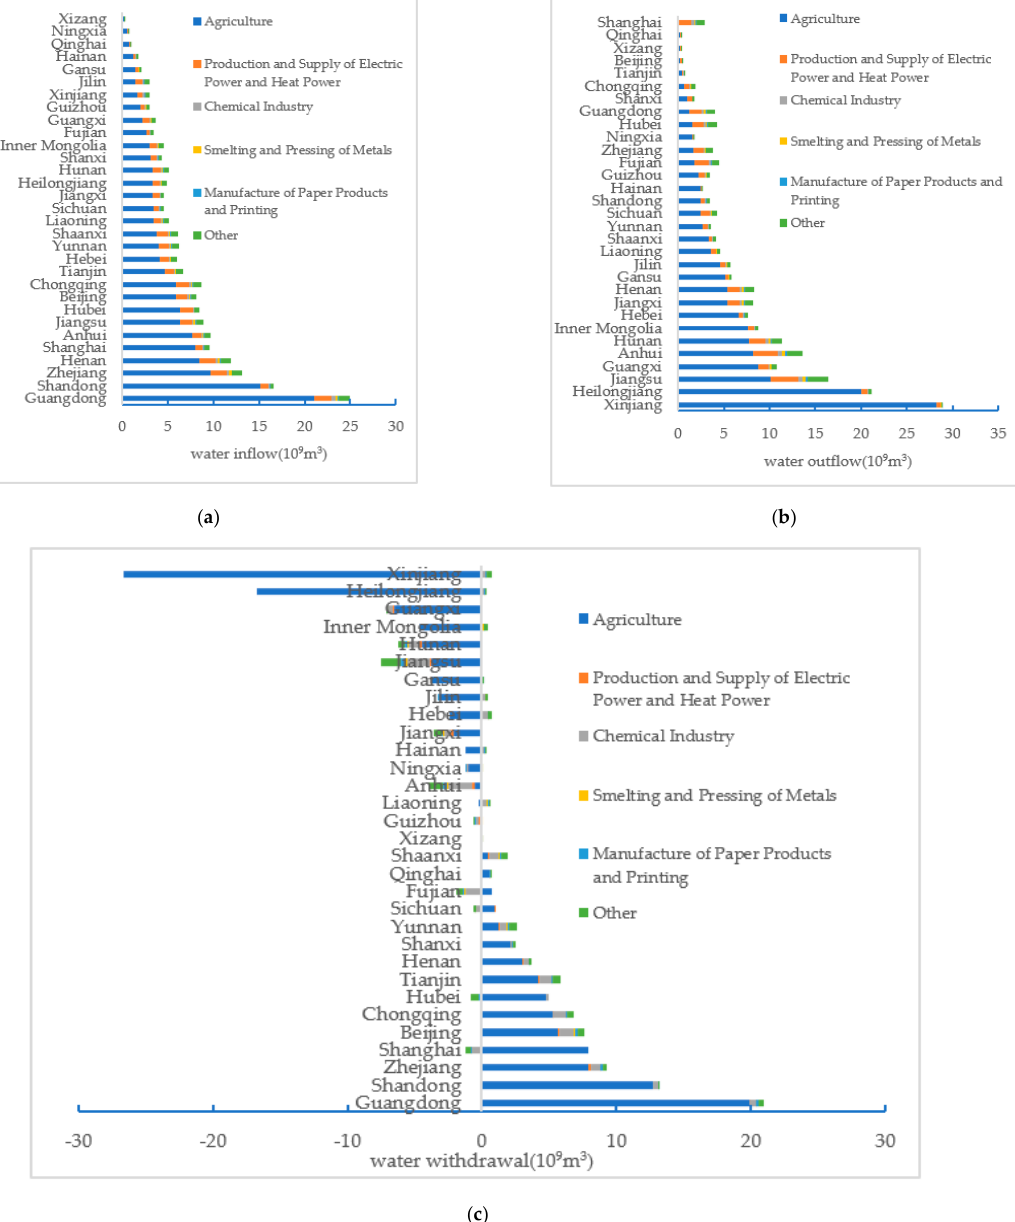
Figure 1. Water inflow ( a ), water outflow ( b ), and water net flow ( c ) of inter-provincial virtual water trade in each province. Note: We only show the top five sectors with the largest virtual water trade volume, and merge the remaining 36 sectors into “other”. In Figure 1c, negative numbers indicate net outflows, and positive numbers indicate net